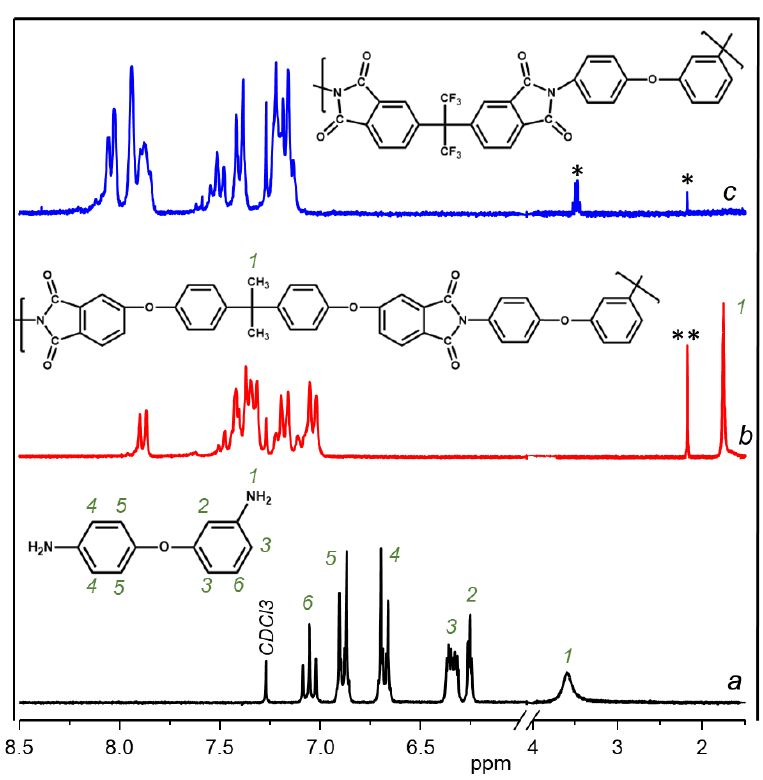
Figure 3. 1 H NMR spectra of 3,4 ′ -ODA (a), PI-DA (b) and PI-6FDA (c) in CDCl 3 (residual solvents: * — diethyl ether, ** — acetone).